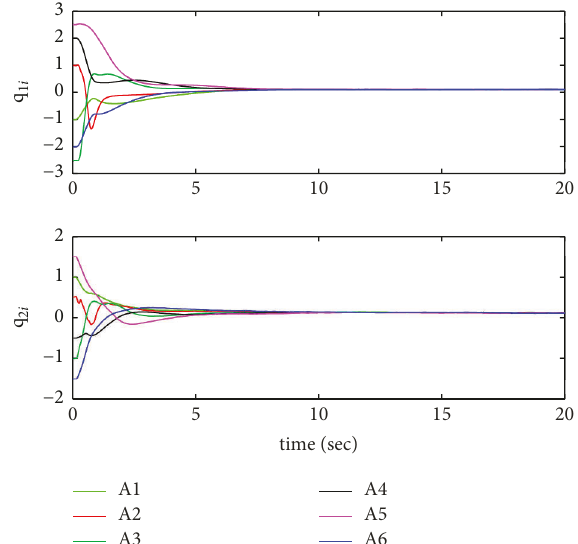
Figure 14: The states q